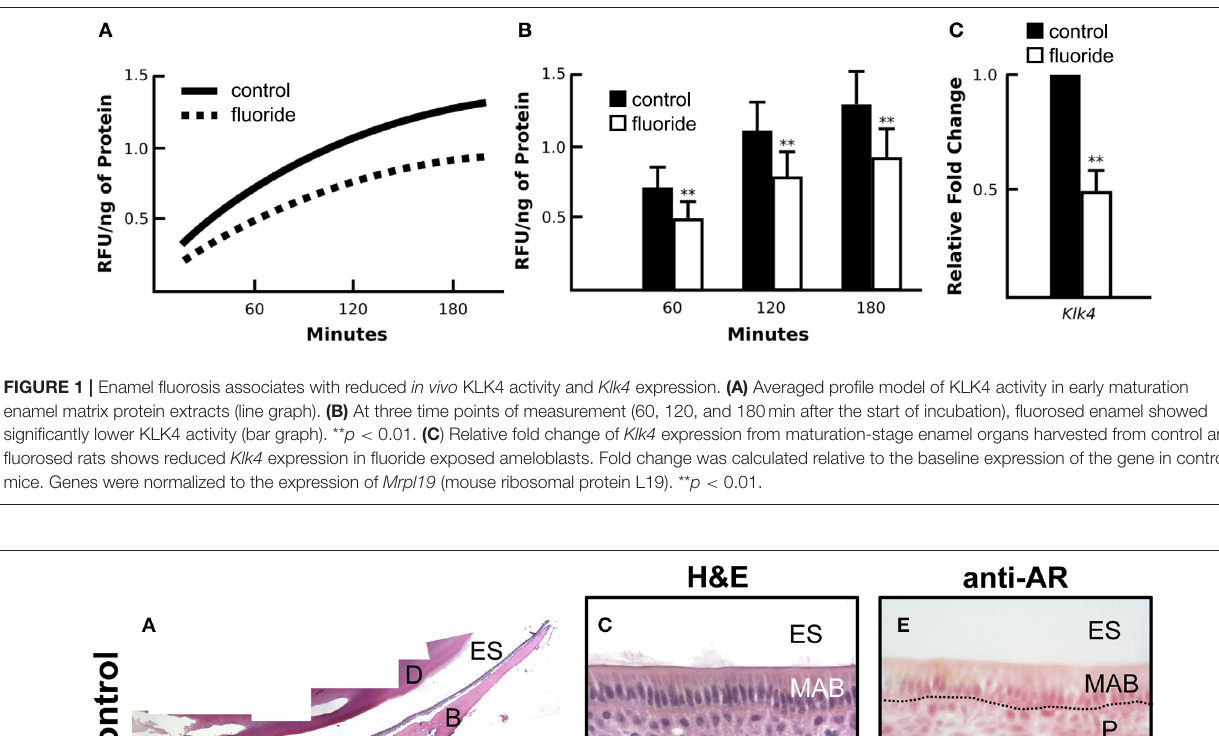
Frontiers in Physiology |